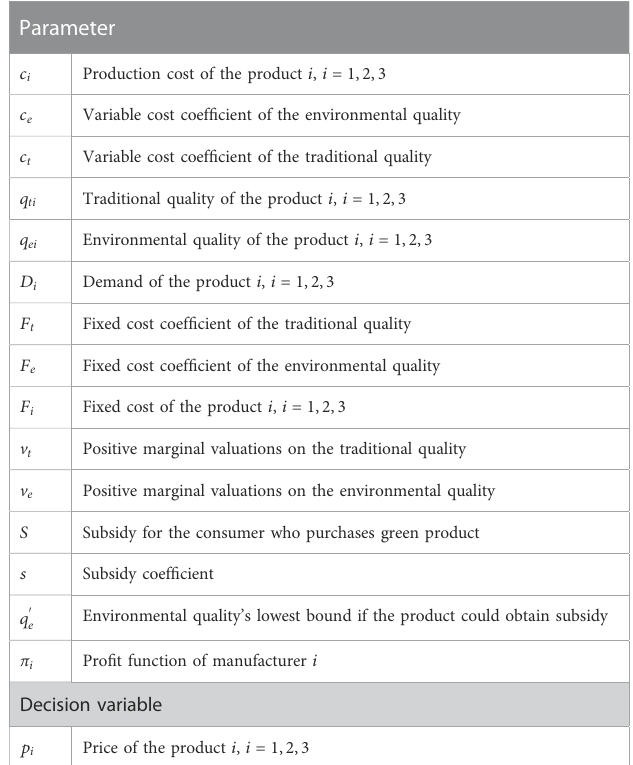
TABLE 2 Model parameters and decision